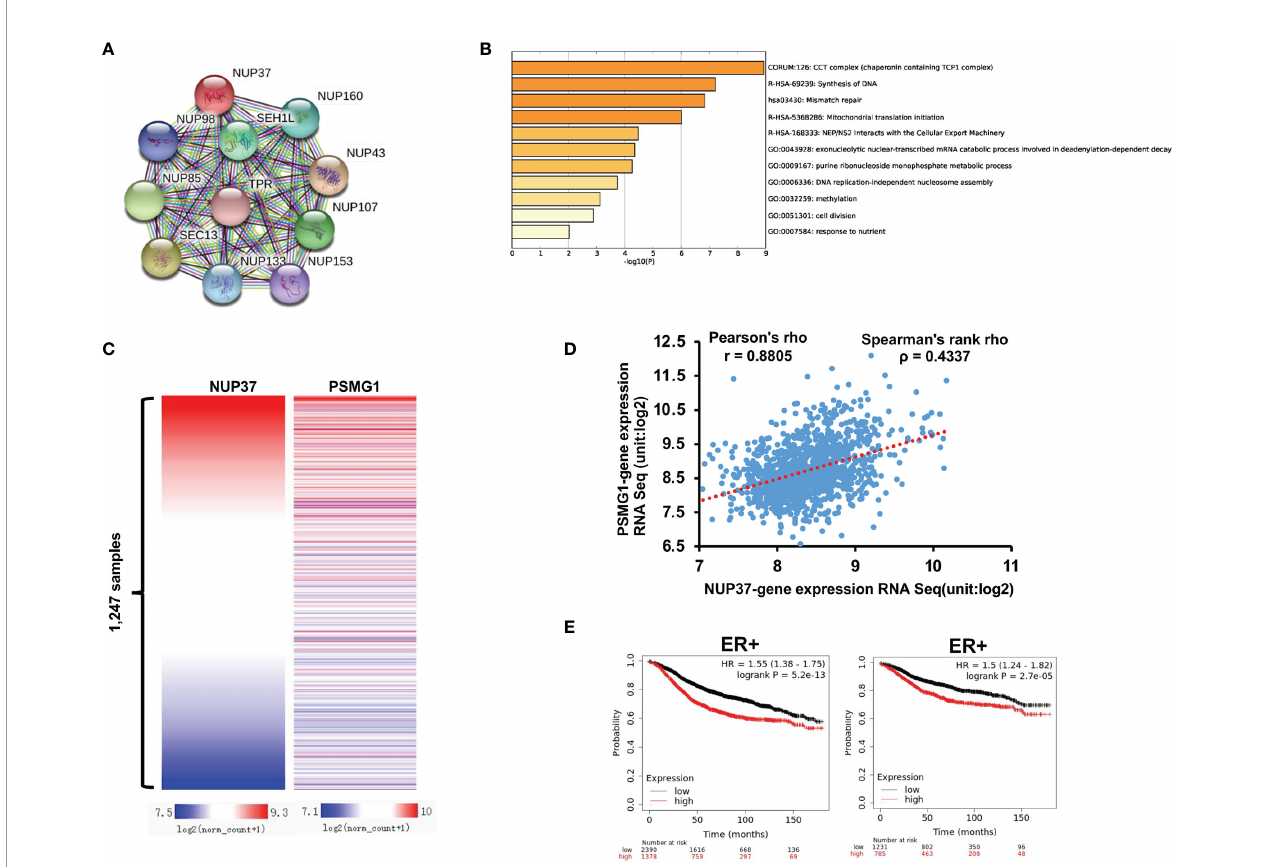
FIGURE 6 | Prediction of potential molecule mechanism of NUP37 in BRCA. (A) The proteins directly interacted with NUP37. (B) The enrichment and annotation of NUP37-related terms using Metascape analysis. (C) Heatmap of the co-expressed relationship between PSMG1 and NUP37 based on TCGA-BRCA database. (D) Co-expression analysis of PSMG1 and NUP37. (E) Correlation of PSMG1 expression with RFS (left) and DMFS (right) curves calculated by Kaplan – Meier plotter for patients with breast cancer classi fi ed as ER+. Statistical signi fi cance was estimated using a log-rank test.